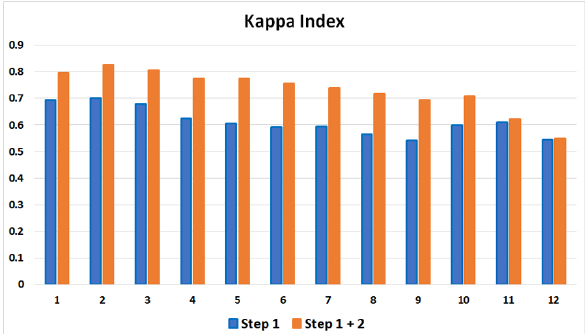
Figure 10. Kappa Index Values